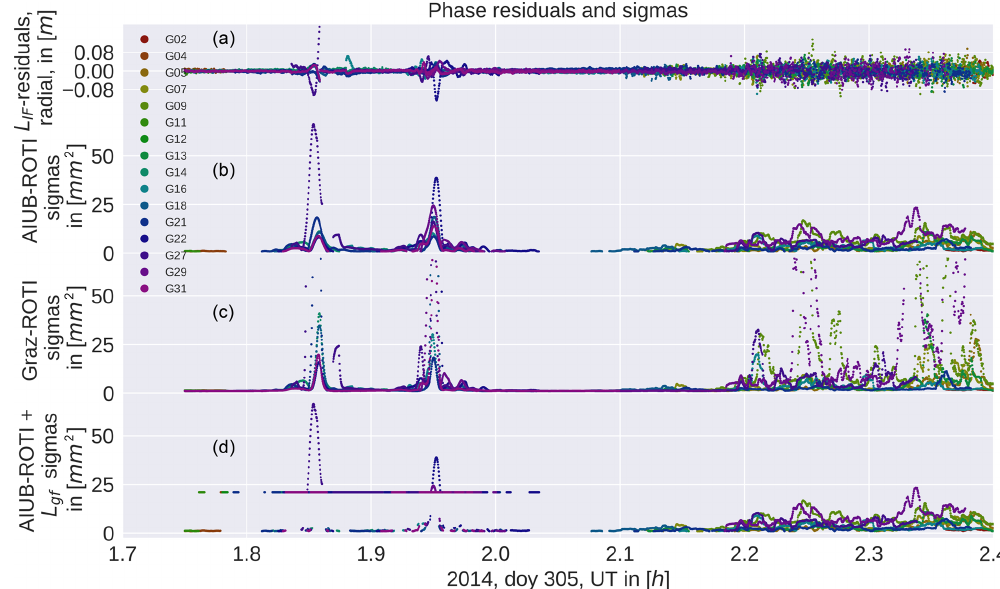
Figure 7. From (a) to (d) : ionosphere-free phase residuals, AIUB-ROTI sigma squares, Graz-ROTI sigma squares, and AIUB-ROTI com- bined with the second derivative. Around 1 . 9UT there is an equatorial pass and around 2 . 3UT a polar pass. The ROTI sigma squares are larger at the polar region; the second derivative with a fixed sigma square (bottom) is only used near equatorial regions. Only sigma squares unequal to 1mm 2 were